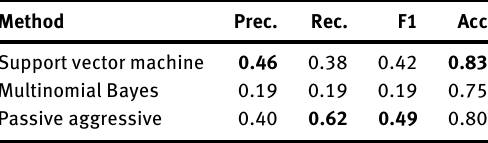
Table 5: Cross evaluation results.